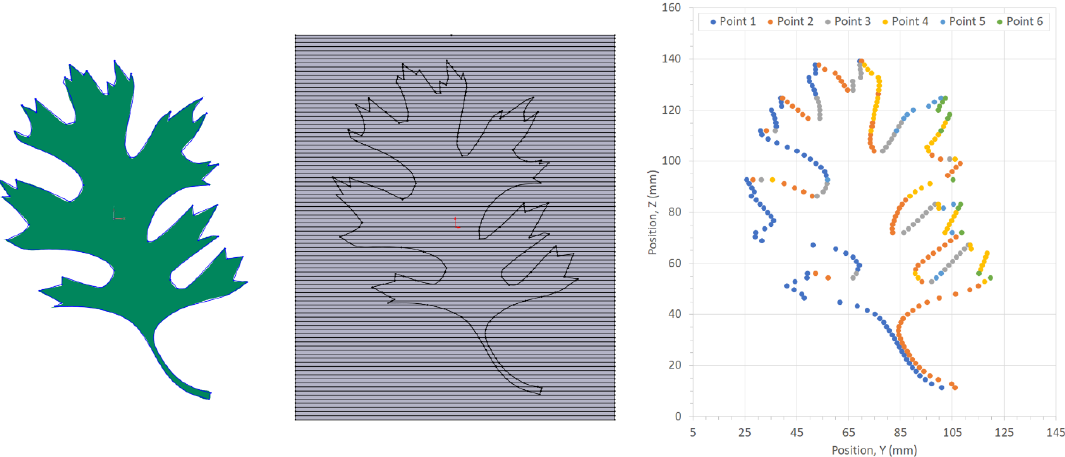
Figure 5. Generalized workflow for oak leaf trigger point generation. From Left to right: Original sketch, layered geometry, final trigger points.